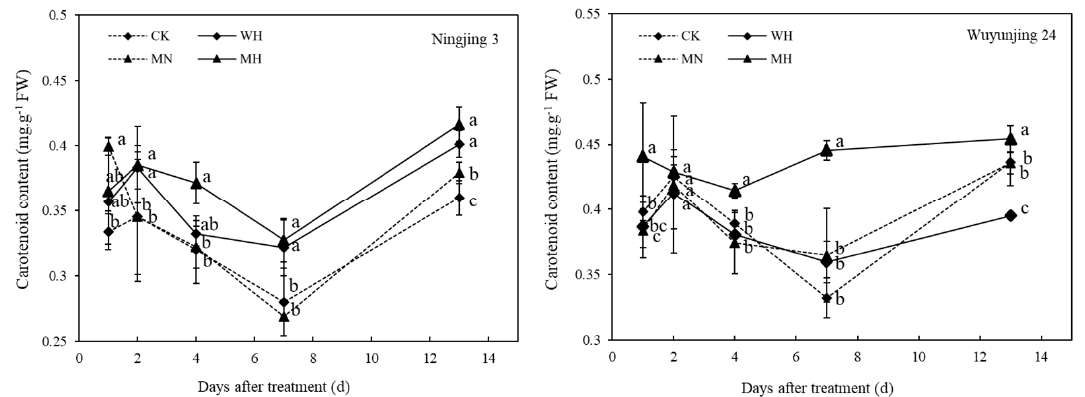
Figure 5. Effects of exogenous MeJA on the carotenoid content (Car) of rice leaves at the booting stage under high temperatures. Note: CK: natural temperature and sprayed with water; MN: natural temperature and sprayed with MeJA; WH: heat stress and sprayed with water; MH: high temperature and sprayed with MeJA. Bars are the standard deviation. Values followed by different letters are significantly different at the 5% probability level.